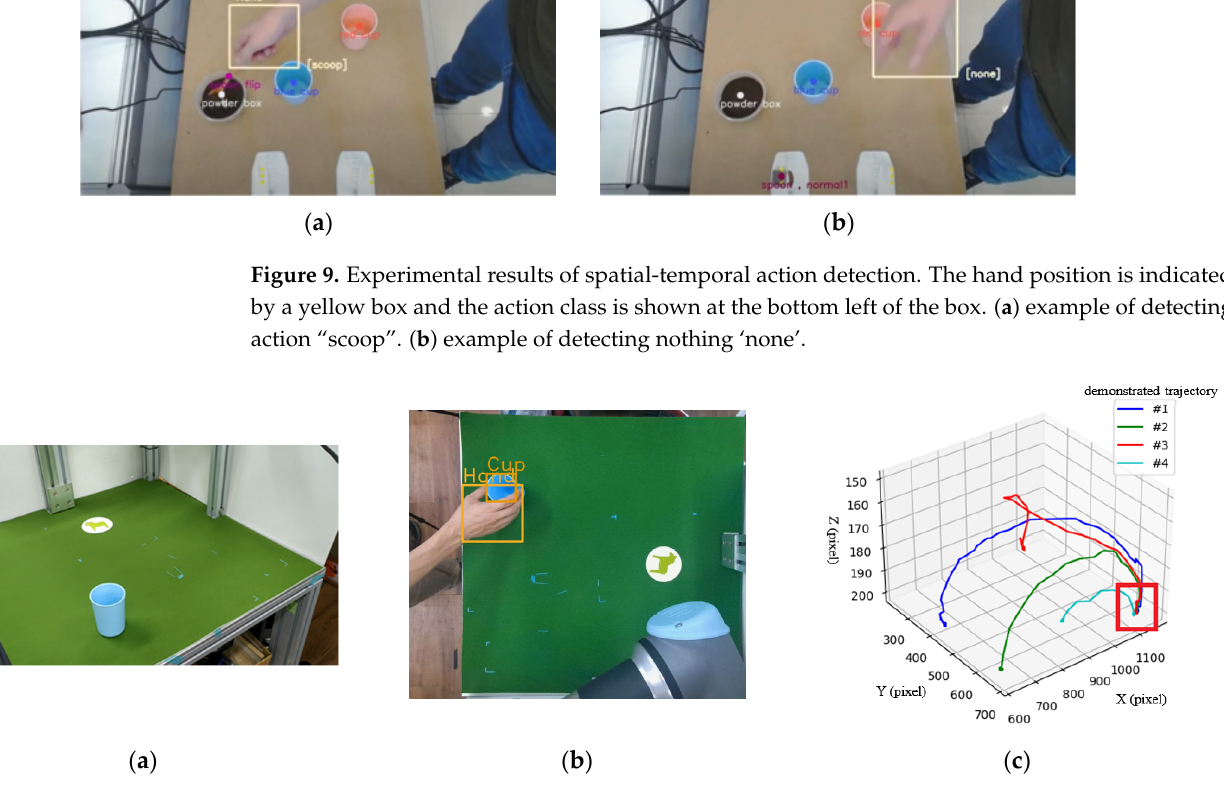
Figure 10. Scenario 1: “pick & place a cup to a fixed position”. ( a ) Experimental environment; ( b ) object detection results; ( c ) absolute trajectory (type-1) of the cup through four demonstrations to induce a key path indicated by a red box.